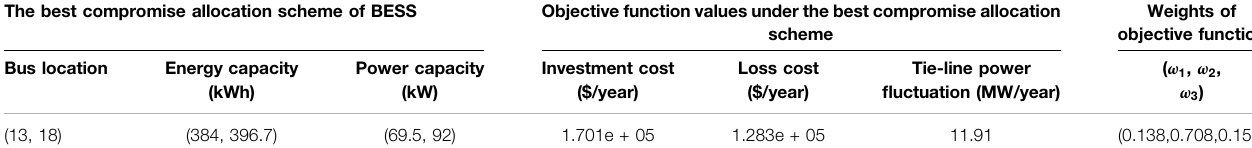
TABLE 2 | Results of NSGA2. The best compromise allocation scheme of BESS Objective function values under the best compromise allocation